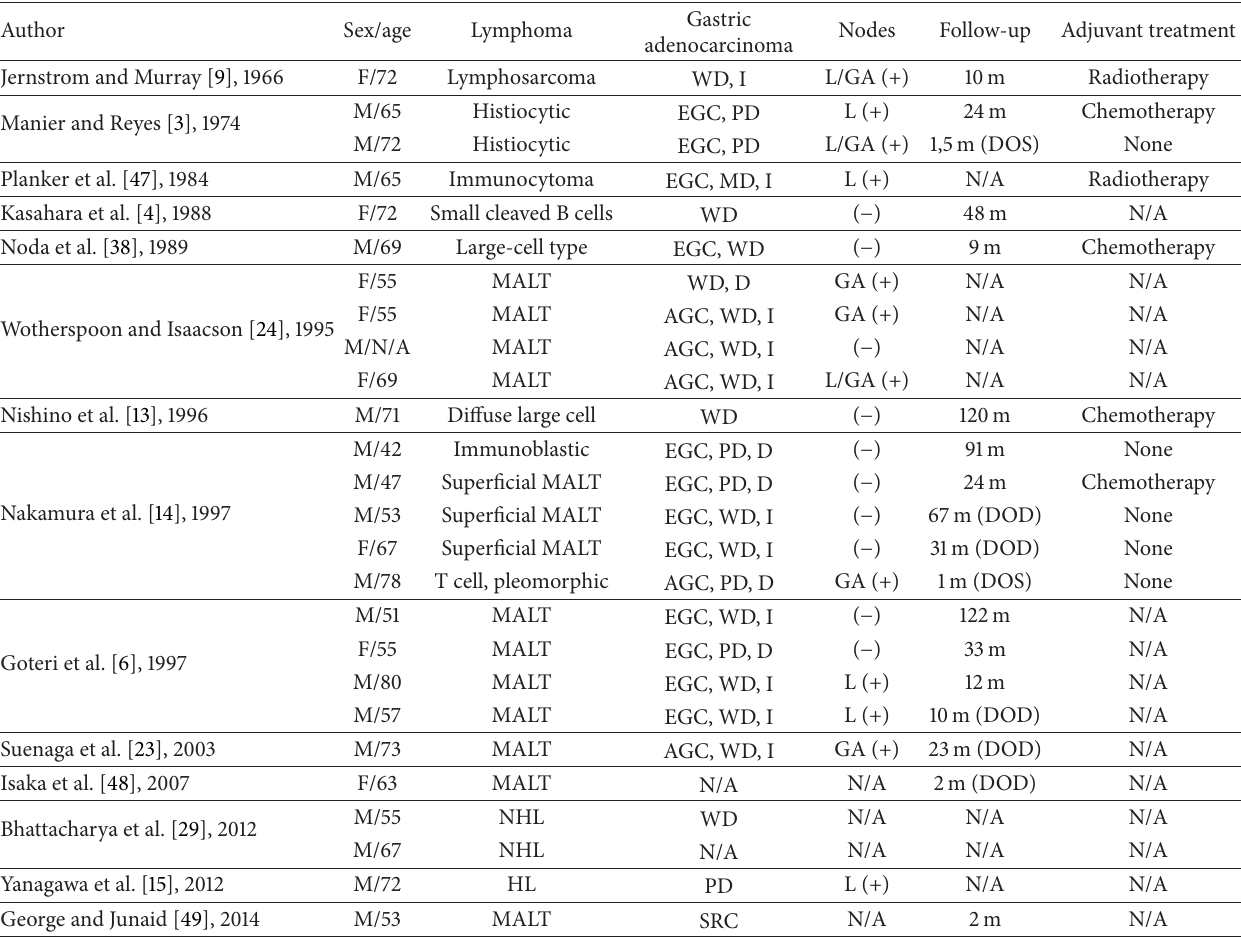
Table 2: Lymphoma and gastric adenocarcinoma collision